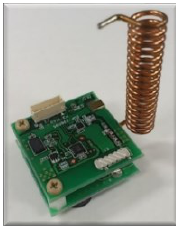
Figure 2. A prototype of wireless sensor.